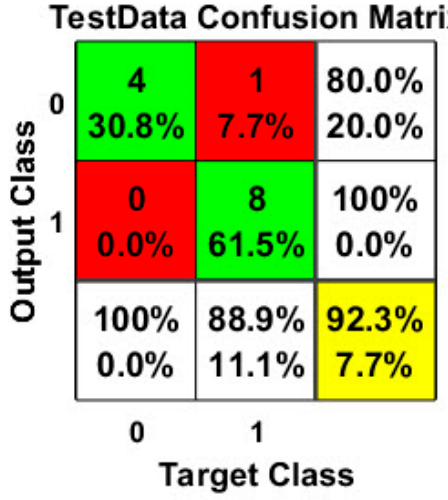
Figure 7. The results of confusion matrix for testing data.